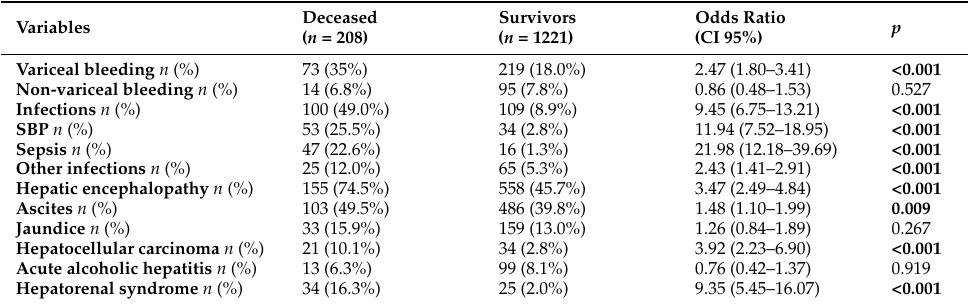
Table 2. Predictive factors—first hospitalization/univariate